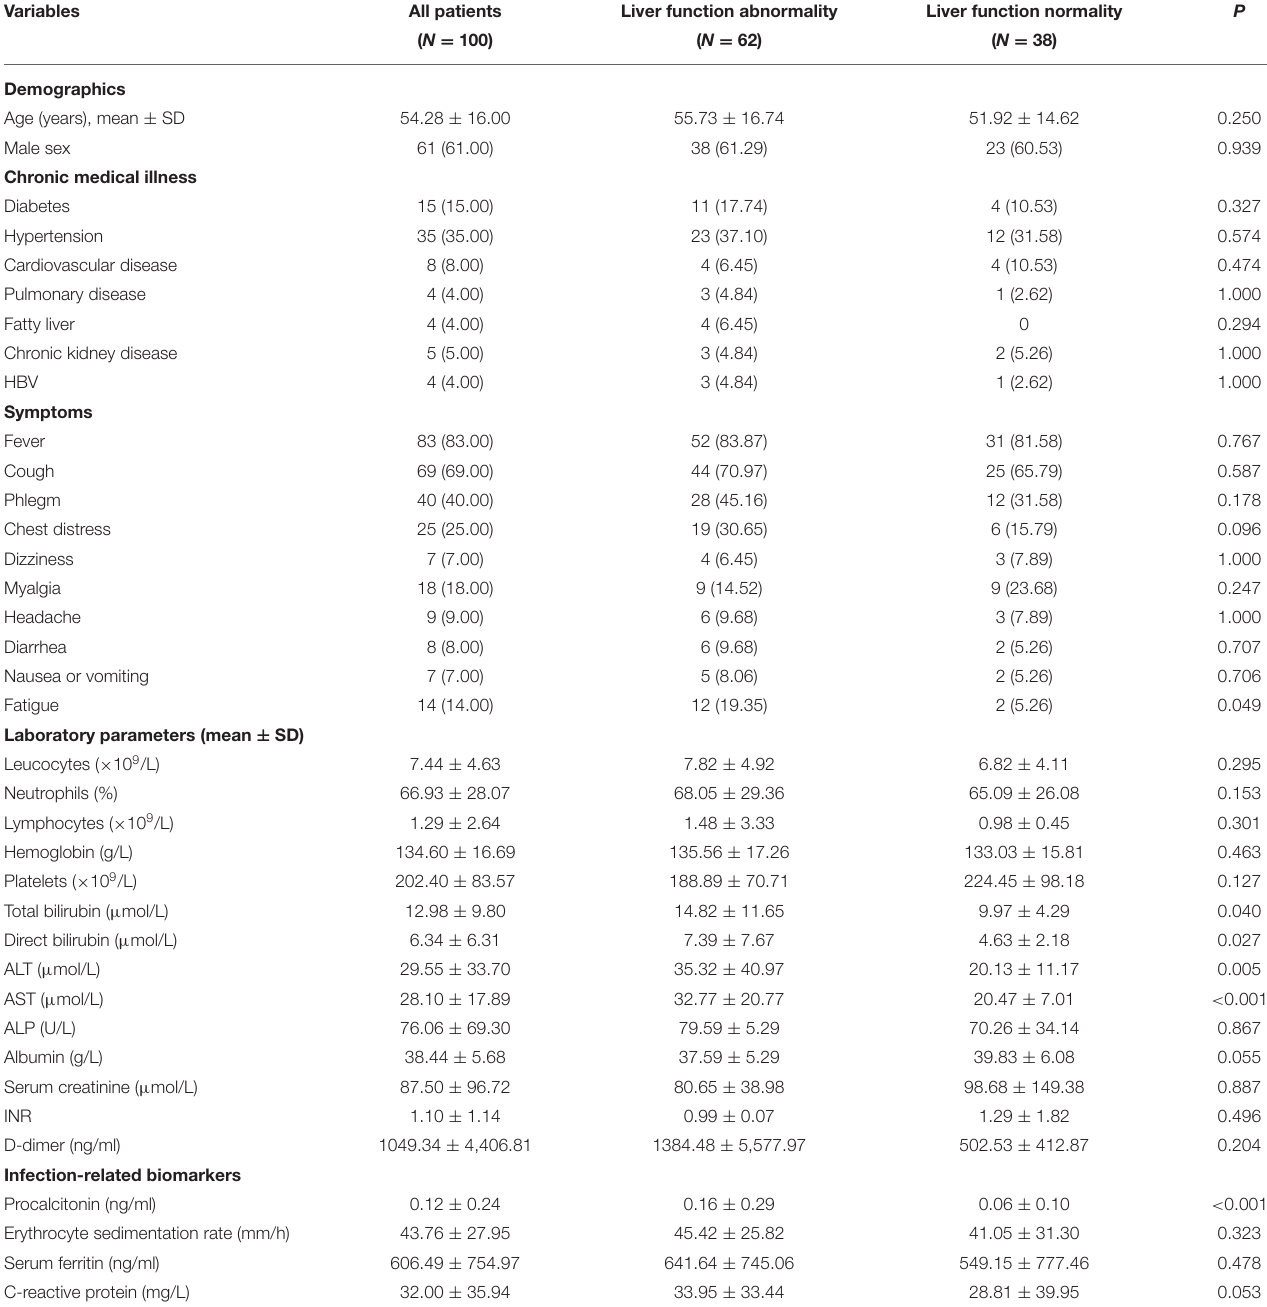
TABLE 1 | Demographics and baseline characteristics of patients infected with COVID-19. Variables All